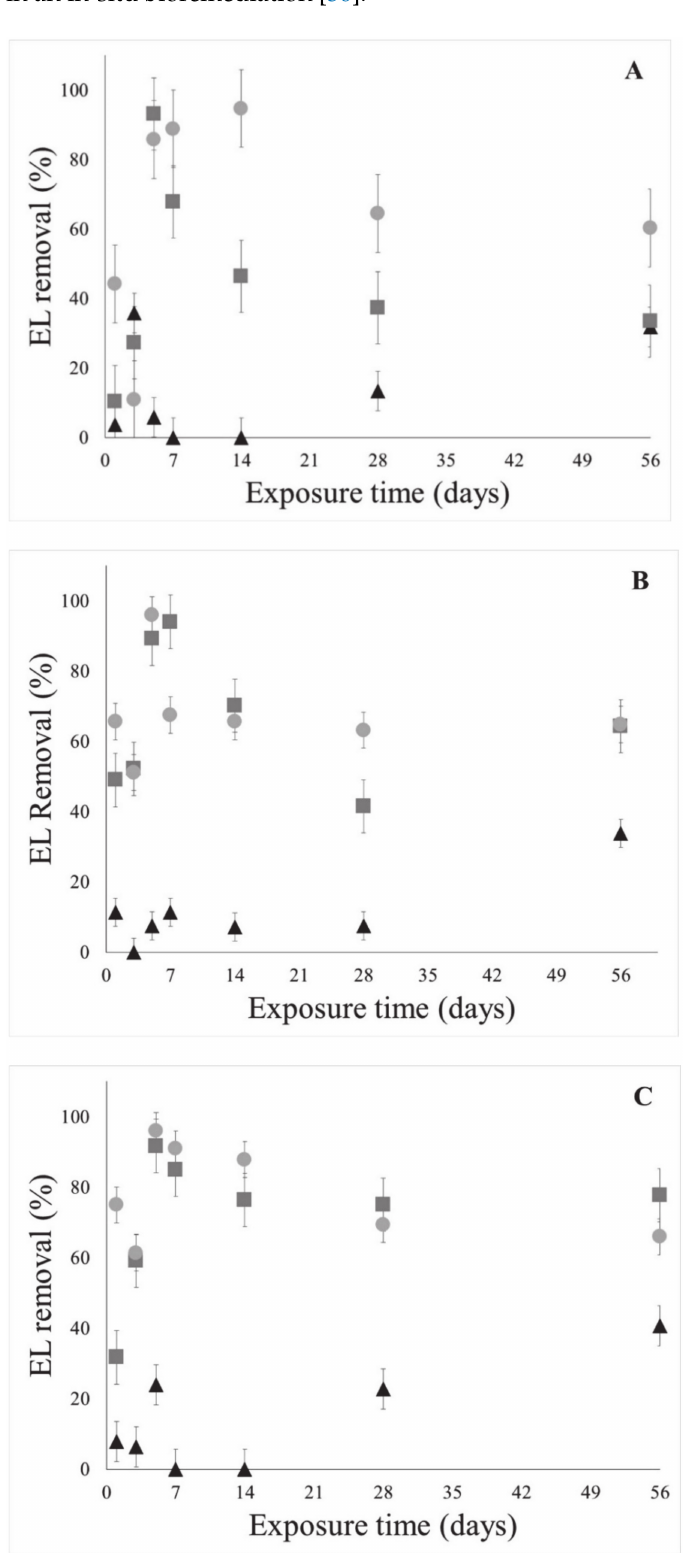
Figure 3. Endosulfan Lactone (EL) removal (%) on non-sterile solid substrate with ( A ) 0.001 mg/kg, ( B ) 0.004 mg/kg and ( C ) 0.009 mg/kg for zero ( (cid:78) ), five ( (cid:4) ) and ten ( • )